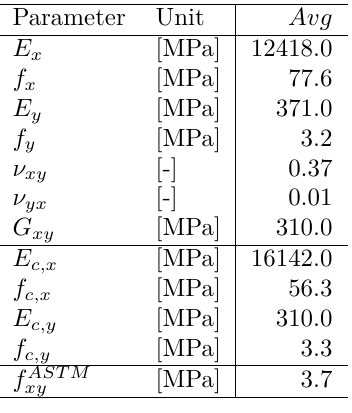
Table 1. Off-axis tension and compression and shear test results for 10 . 5 mm GLT where Avg is the mean (values adopted from [3]).